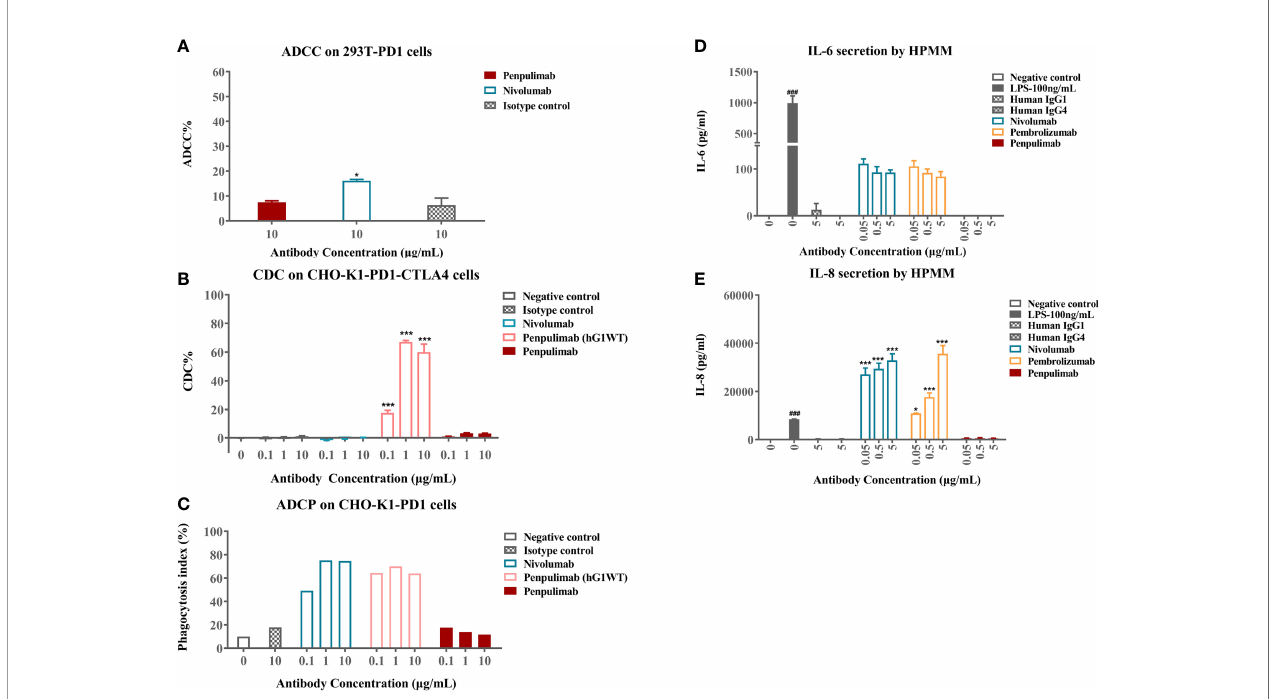
FIGURE 2 | (A) Antibody-dependent cell-mediated cytotoxicity (ADCC) activities of penpulimab and nivolumab were determined by measuring lactase dehydrogenase (LDH) release from 293T-PD1 cells. (B) Complement-dependent cytotoxicity (CDC) activities of penpulimab, penpulimab (hG1WT), a version of penpulimab with wildtype IgG1 backbone, and nivolumab were determined by measuring LDH release from CHO-K1-PD1-CTLA4 cells. (C) Antibody-dependent cellular phagocytosis (ADCP) activities of penpulimab (hG1WT), penpulimab, and nivolumab were studied by examining phagocytosis of CHO-K1-PD1 cells by murine bone marrow derived macrophages (HPMMs). Effects of Fc engineering of penpulimab on the release of in fl ammatory cytokines. (D) IL-6 and (E) IL-8 by HPMMs in the presence of IFN- g . Data are expressed as mean or mean ± SEM and analyzed using one-way ANOVA . * P <0.05 and *** P <0.001 vs. isotype control; ### P <0.001 vs. negative